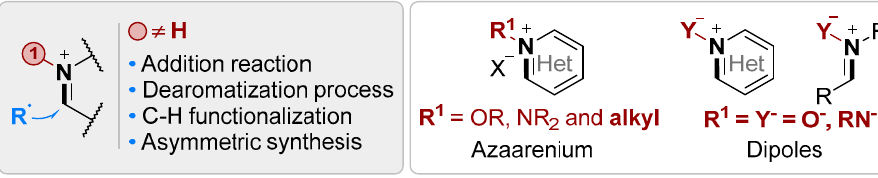
Figure 3. Radical-based transformations of azomethine imines. The photoirradiation of nitrones usually leads to photoexcited counterparts that cy- clize into oxaziridine. In order to overcome this pathway, Itoh, Suga and colleagues pro- posed in 2015 a photoinduced electron transfer (PET) process of a photoexcited nitrone 2 and a tertiary amine 1 (Scheme 1). Upon irradiation with a UV-LED, in acetone as solvent, the authors demonstrated a smooth addition of the amine 1a to 2a , leading to the for- mation of adduct 3a in 61% yield after 2.5 h. Interestingly, in the presence of a catalytic amount of benzophenone (BP, 10 mol%) as a photosensitizer, the addition reaction was accelerated and took place with 2a in only 0.7 h to deliver 3a in 62% yield. A screening of conditions revealed the 4,4 ′ -dichlorobenzophenone (DCBP) as a more efficient photosen- sitizer allowing an improved yield of 76% ( 3a ) after 1.3 h.